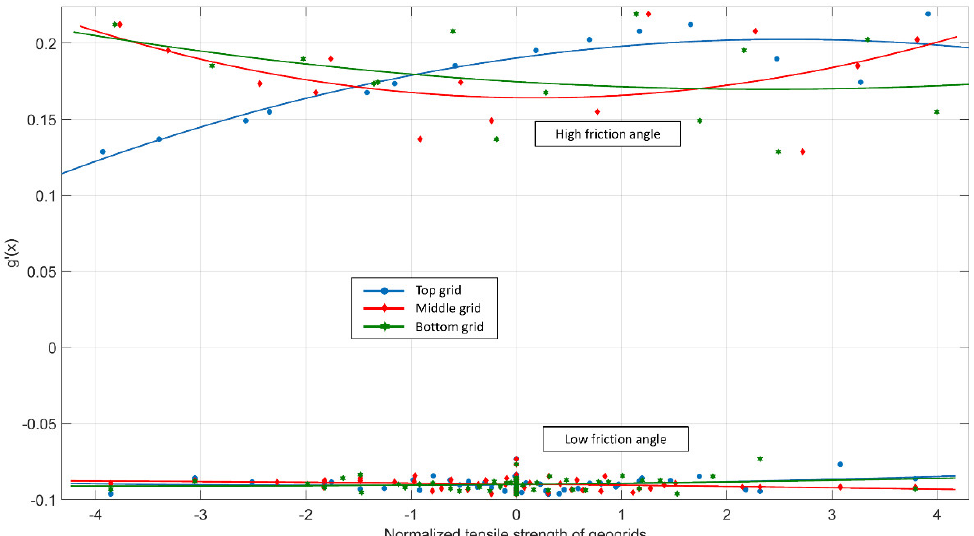
Figure 14. Effect of tensile strength of all geogrid layers on the performance function for mean interface friction angle, for two different values of reconstruction material friction angle.